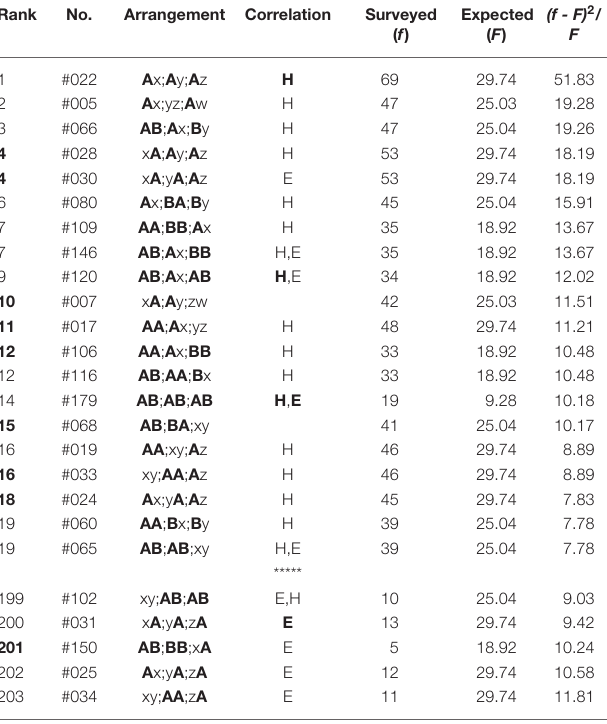
TABLE 8 | The top-twenty and the bottom-five arrangements in the latter three phrases (5-7-7) of poems in Collection of Ten Thousand Leaves , wherein there are 4183 tanka poems included.